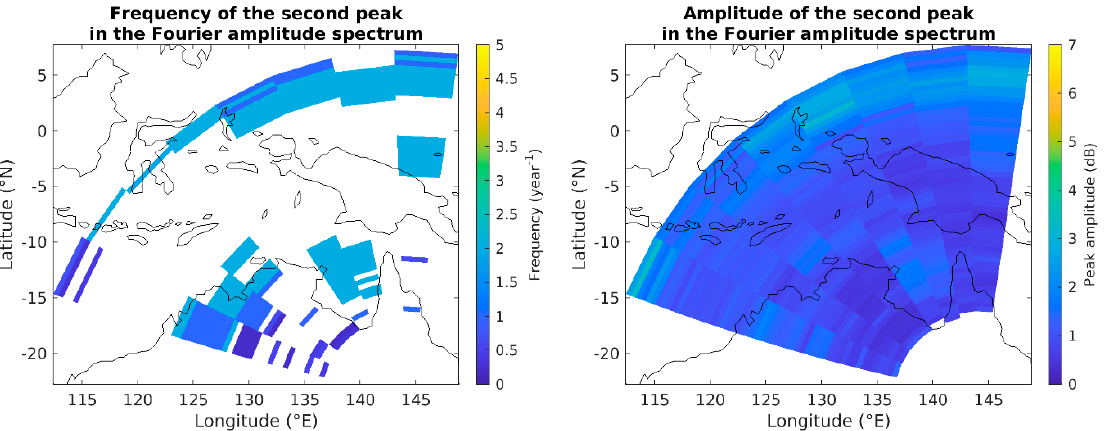
Figure 13. ( Left ): The frequency of the secondary peak from the FFT for each LO range-azimuth cell. ( Right ): the amplitude of the second largest peak from the FFT for each LO range-azimuth cell. Range-azimuth cells with greater than 50% missing data are excluded from the Fourier analysis.